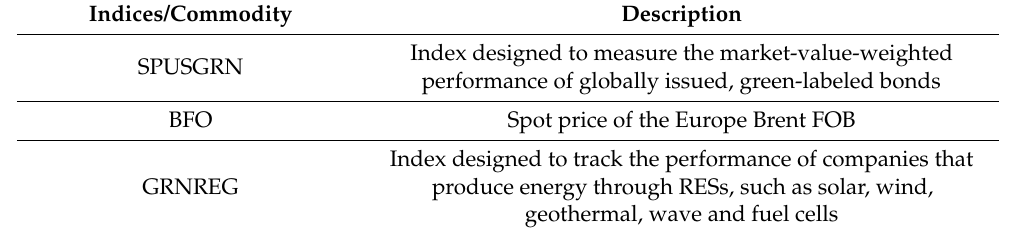
Table 1. Description of the variables investigated in the research. Indices/Commodity Index designed to measure the market-value-weighted